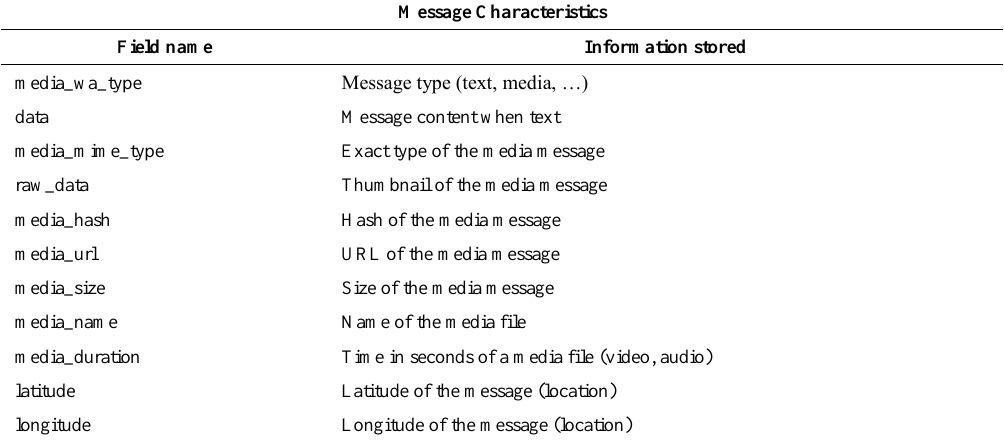
Table 9. Structure of the chat database msgstore.db - message content